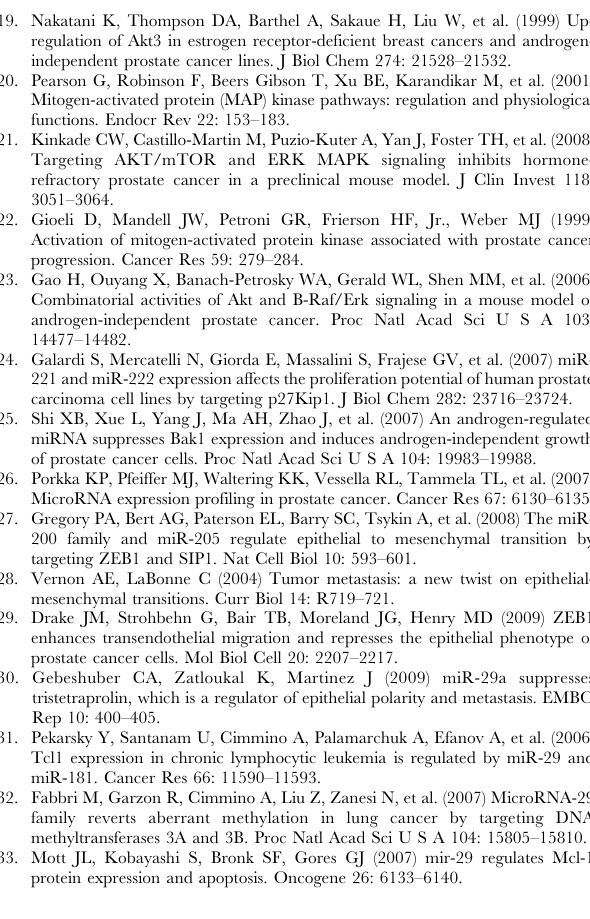
Table S1 The known miRNAs expressed in LNCaP and LNCaP-AI libraries.